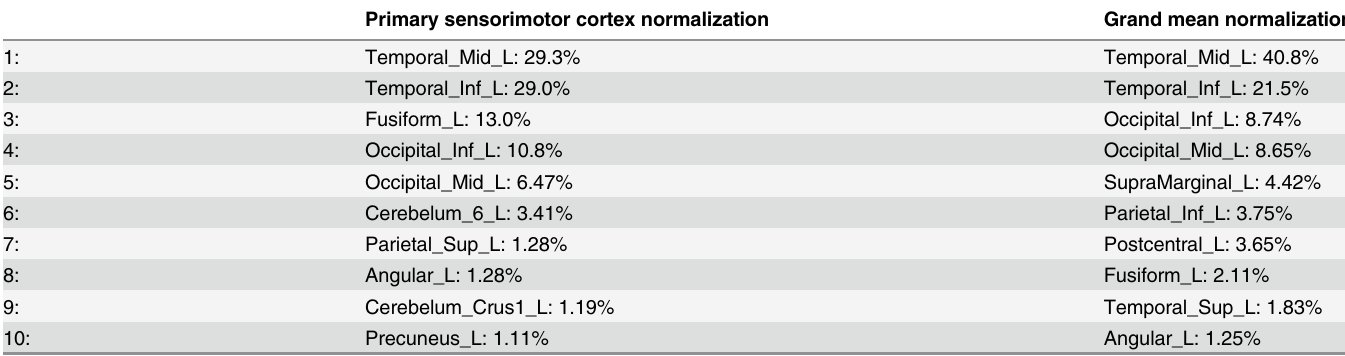
Table 7. Top-10 informative regions (voxels) of MCI against AD using TUM dataset using BIC. Primary sensorimotor cortex normalization Grand mean